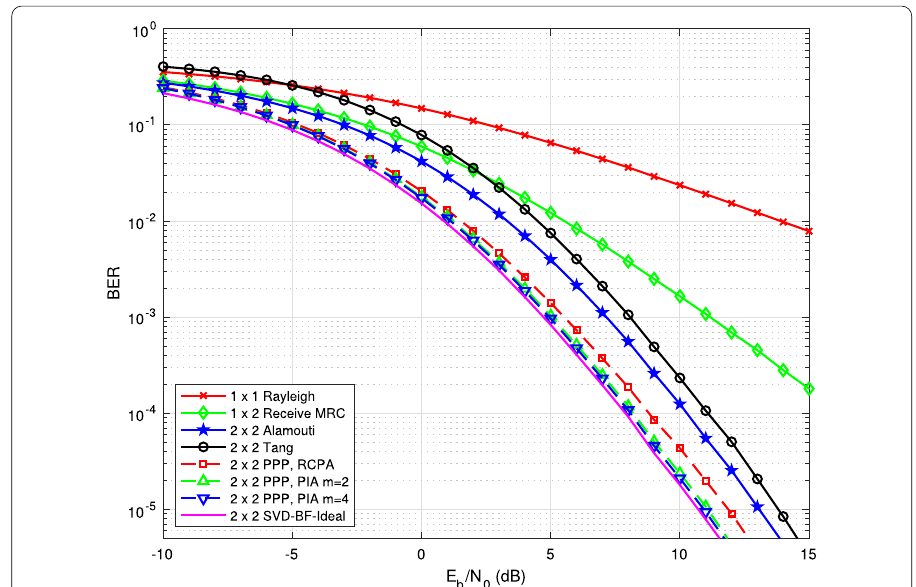
1 ), MRC receive diversity ( 1 × 2 ) schemes (RCPA with m ×